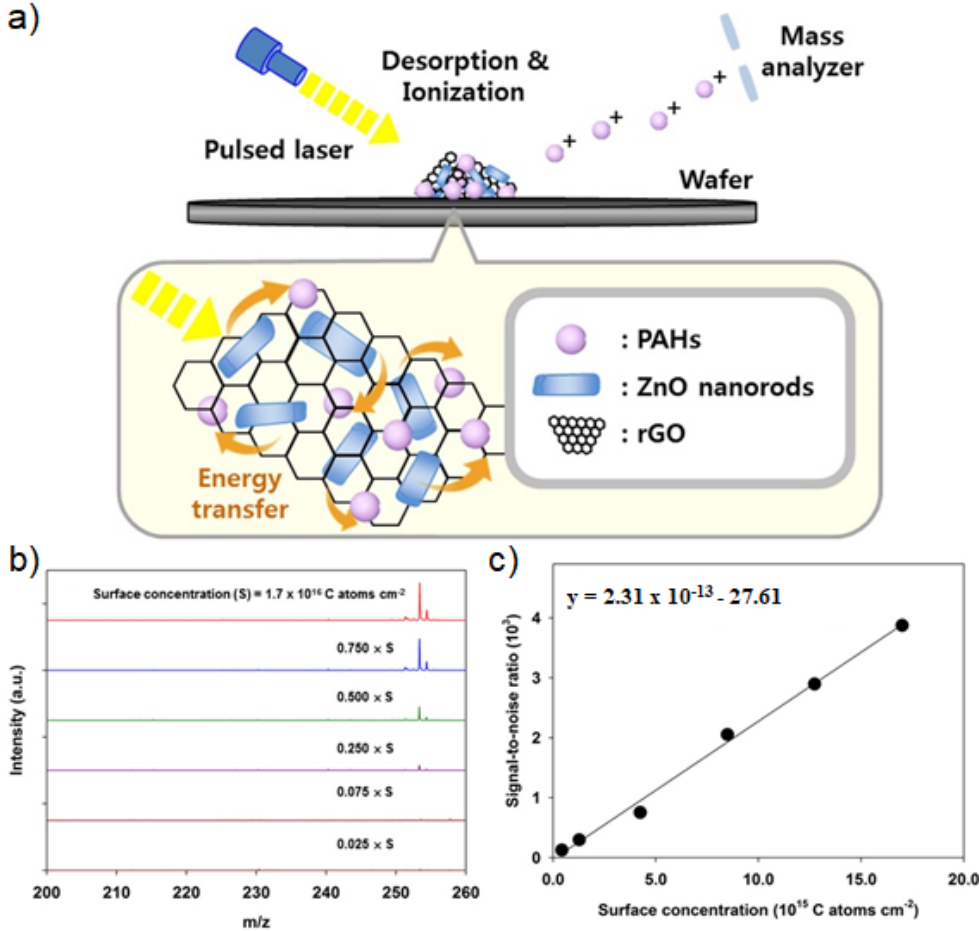
Figure 8. ( a ) Schematic diagram of the structure and LDI-TOF-MS application of ZnO/RGO nanohybrid structures. ( b ) LDI-TOF-MS spectra and ( c ) standard concentration curve of B[a]P obtained with ZnO/RGO nanohybrid structures with different concentration. Adapted with permission from ref. [93]. Copyright (2018)